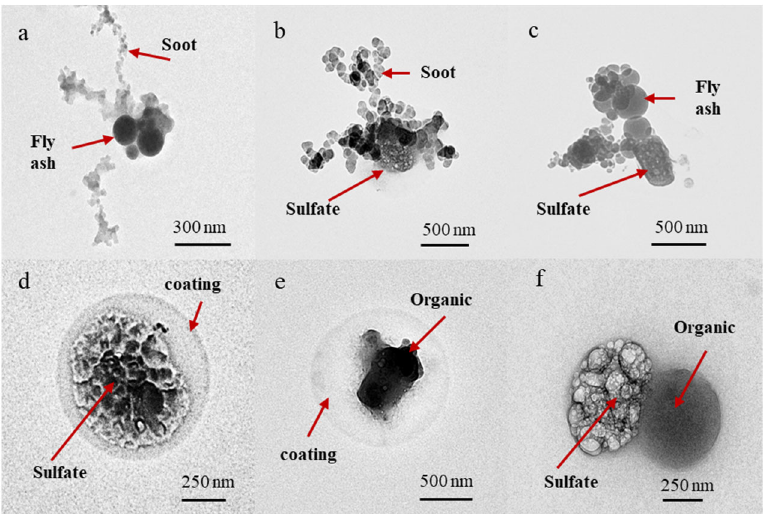
Figure 2. TEM images of mixed individual particles in the winter haze of Xi’an during the sampling period. ( a ) Soot–fly ash mixed particle. ( b ) Sulfate–soot mixed particle. ( c ) Sulfate–fly ash mixed particle. ( d , e ) Mixed particles with core–shell structures. ( f ) Sulfate–organic mixed particle.